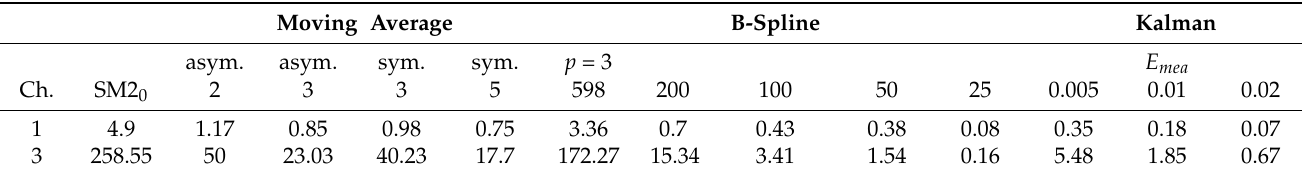
Table 5. The values of the SM2 performance metric for moving average, B-spline, and Kalman filters for signals from channels 1 and 3 of the root-joint for the kicking model using various control parameters.